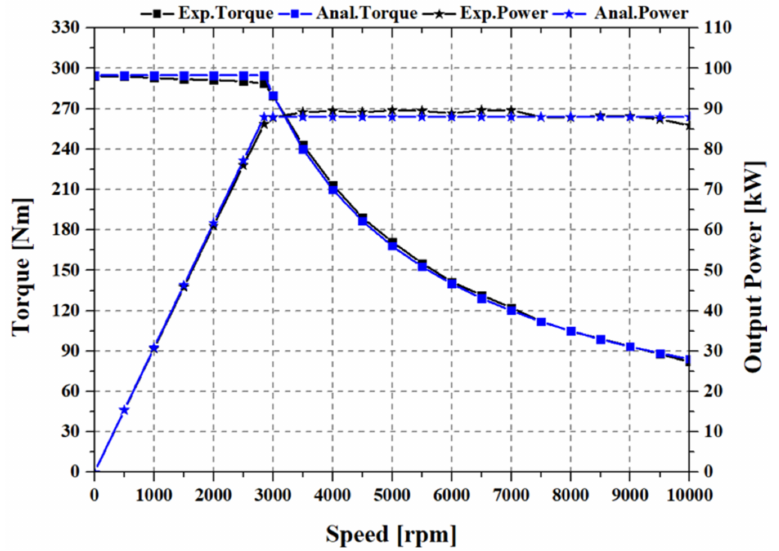
Figure 21. The experimental